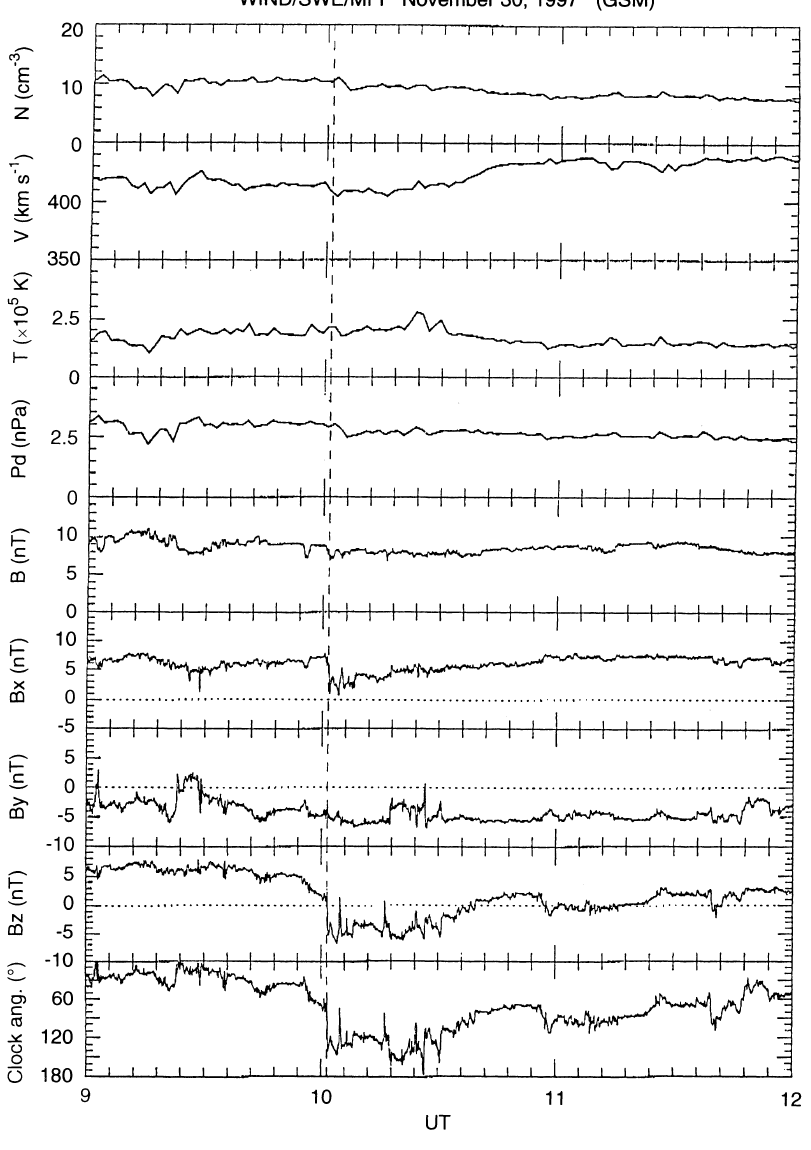
Fig. 1. Solar wind plasma and IMF observa- tions from Wind on November 30, 1997. Shown from top to bottom are proton density (in cm 3 ), bulk speed (in km/s), proton temperature (in K), dynamic pressure (in nPa), the magnetic field magnitude and components B x , B y , and B z (in nT) and the IMF clock angle (degree). The southward turning of the IMF at 1000 UT is marked by a vertical